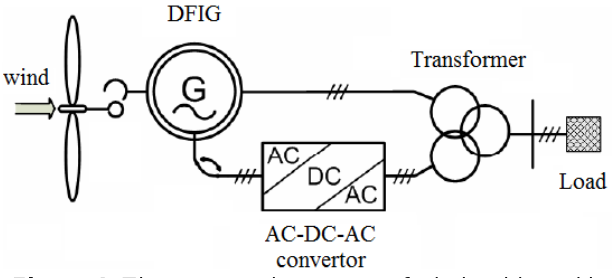
Figure 1. The proposed structure of wind turbine with